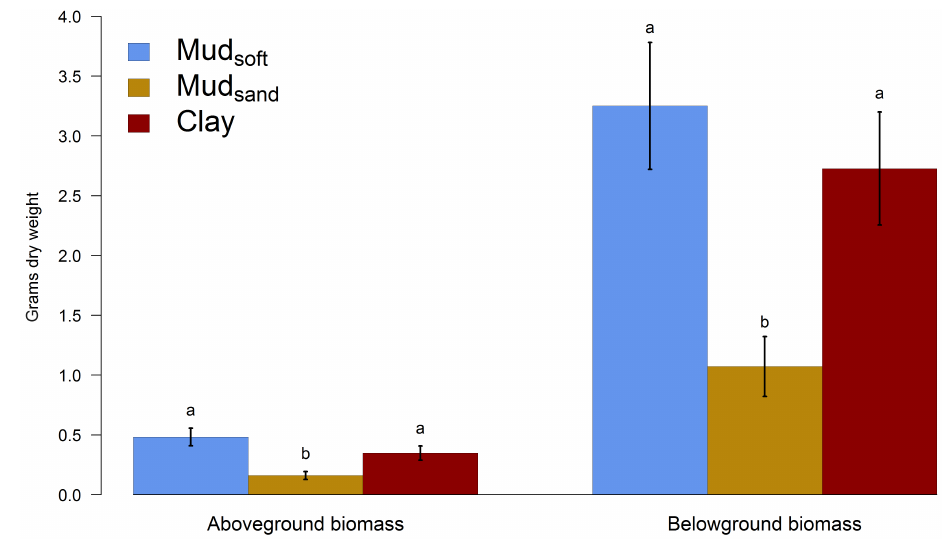
Figure 3. Above- and belowground biomass in grams dry weight, with error bars ( n = 5). Significant differences between sediment types are indicated by different letters, and nonsignificant differences are indicated by the same letter.